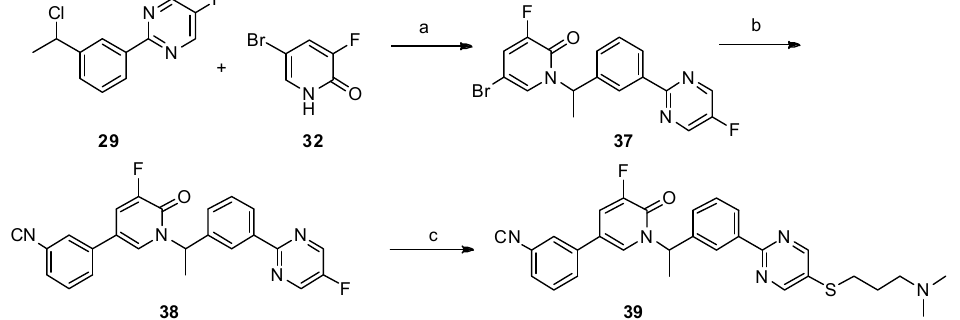
Table 1. Structures and antiproliferative activity of target compounds